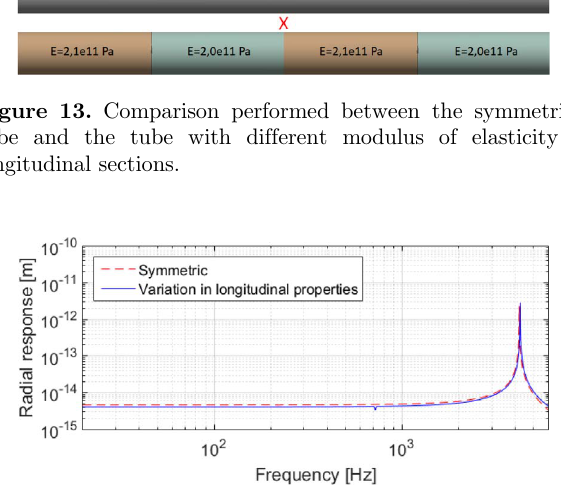
Figure 14. Calculated de fl ection at the point at 0.3 L of the symmetric and asymmetric tube in the longitudinal sections, excited by unit internal pressure.